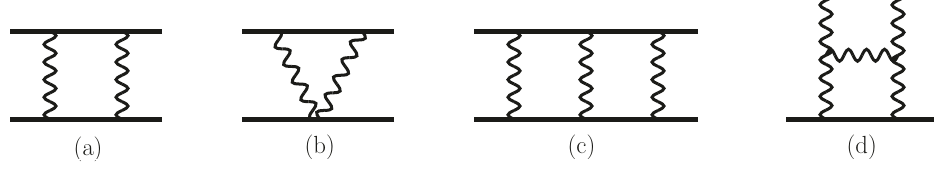
Figure 2 . Examples of one- and two-loop diagram that contribute to the classical potential. Wiggly lines represent gravitons and straight lines scalars. Here the diagrams are not Feynman diagrams, but demonstrating the singularity structure from propagators in the graphs.